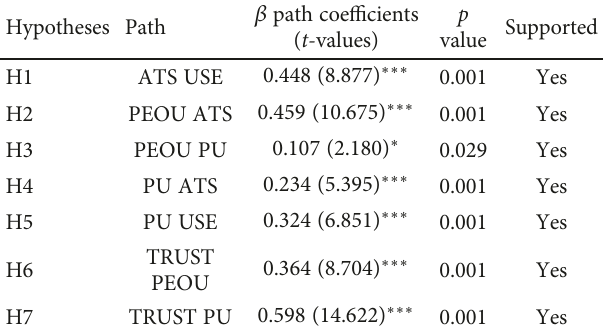
Table 6: Statistical hypothesis